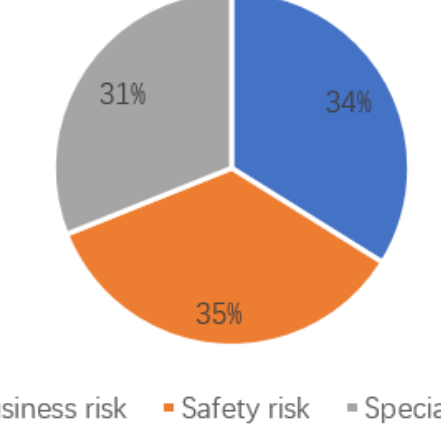
Figure 5. Failure type NOR F − RPWN̅̅̅̅̅̅̅̅̅̅̅̅̅̅ pie chart.